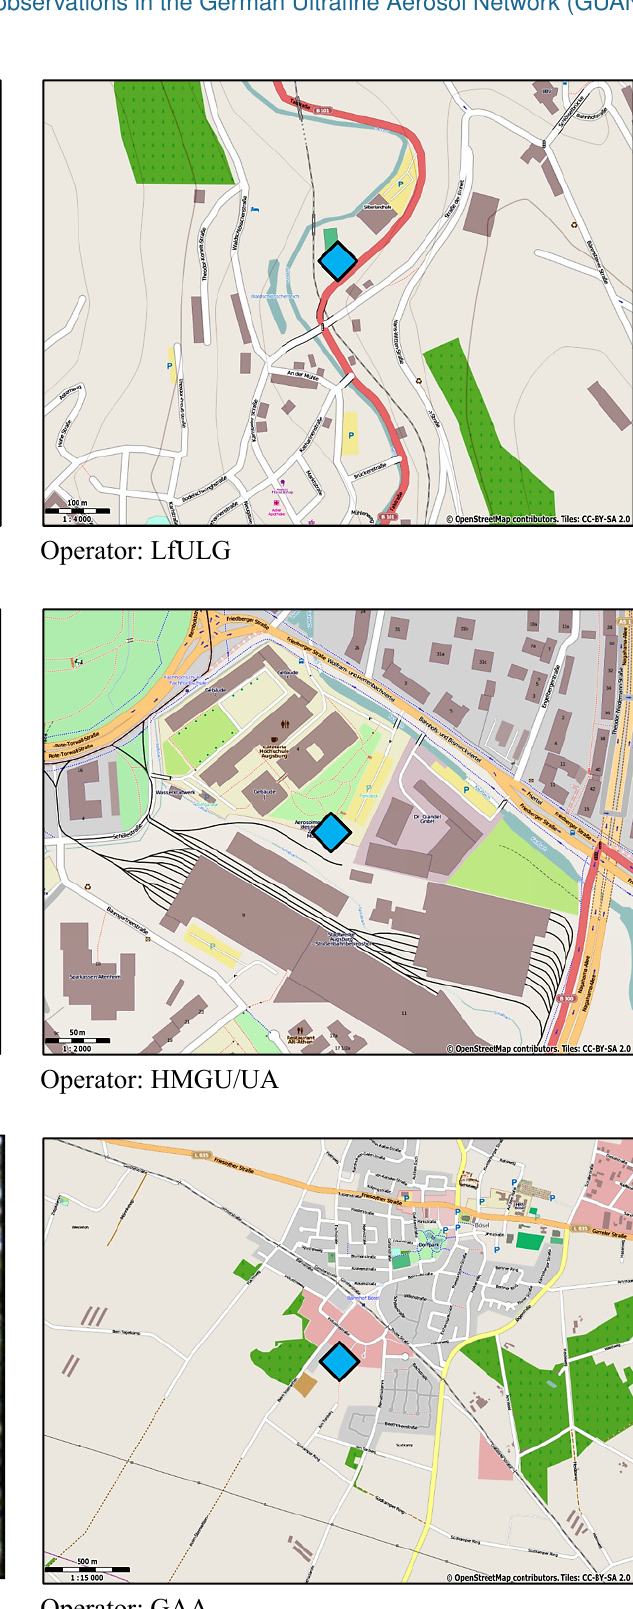
Earth Syst. Sci. Data, 8, 355–382,